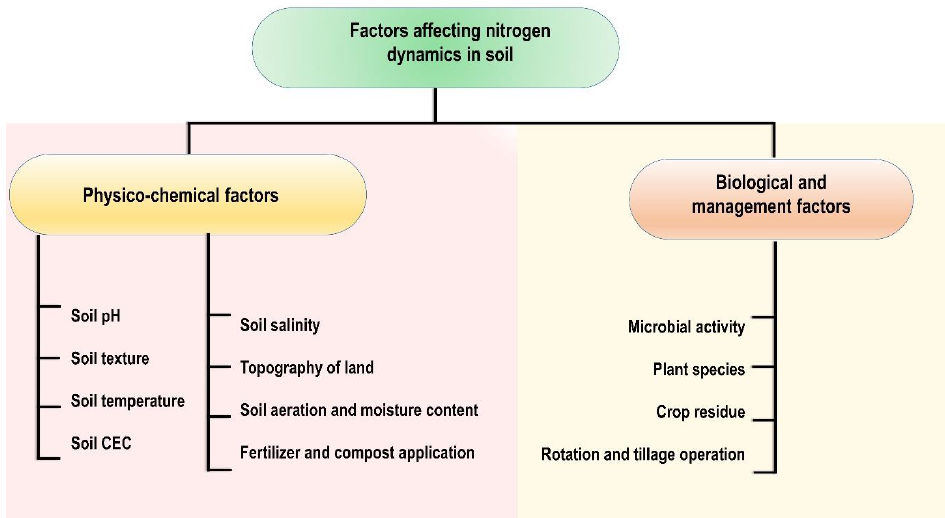
Figure 6. Factors affecting N dynamics in